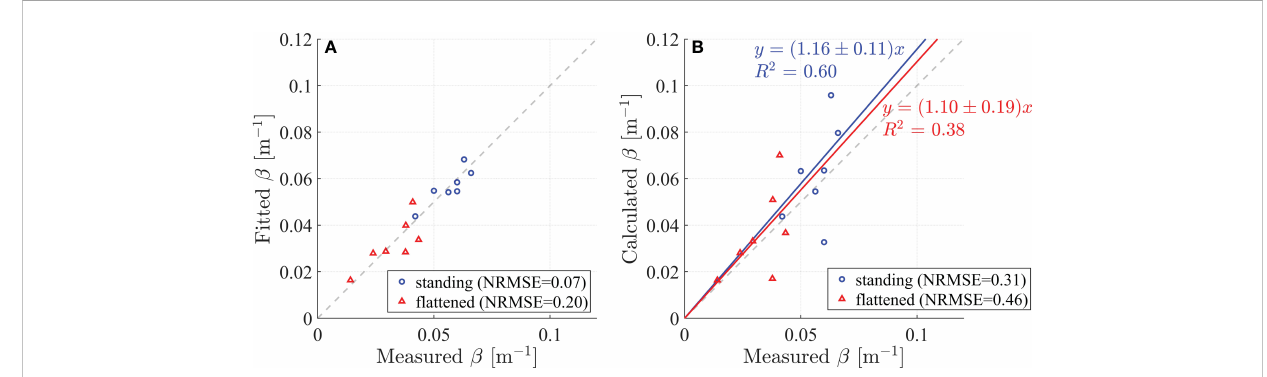
FIGURE 5 (A) Comparison between measured and fi tted wave damping coef fi cients ( b ). (B) Comparison between measured and calculated b . The results for standing and fl attened vegetation are denoted by blue circles and red triangles,